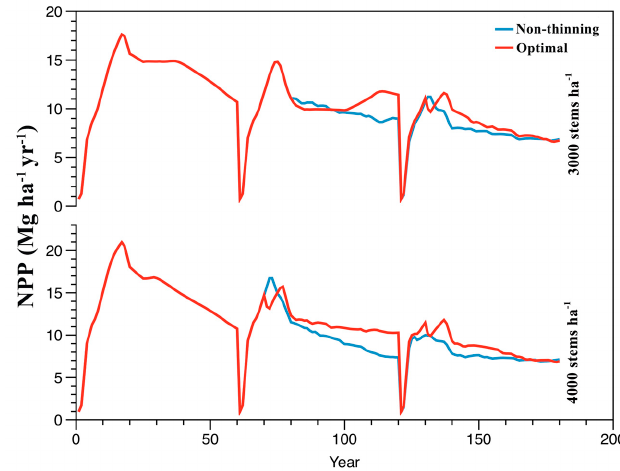
Figure 4. NPP in stands with different initial stand densities in three rotations. Blue lines represent non-thinning, red lines represent optimal treatments. For the 3000 stems ha − 1 stands, 25% thinning intensity and application of thinning in the 20th year occurred in Rotation 2 and 25% thinning intensity and application of thinning in the 10th year occurred in Rotation 3. For the 4000 stems ha − 1 stands, 25% thinning intensity and application of thinning in the 10th year occurred in Rotation 2 and 40% thinning intensity and application of thinning in the 10th year occurred in Rotation 3.